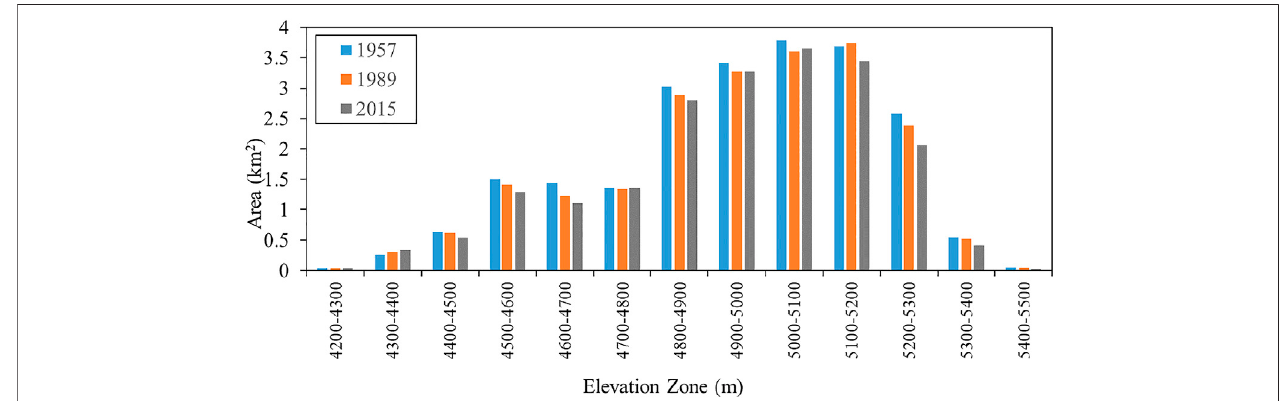
FIGURE 2 | Distribution of area in elevation zone (1957, 1989, and 2015) with 100 m interval.